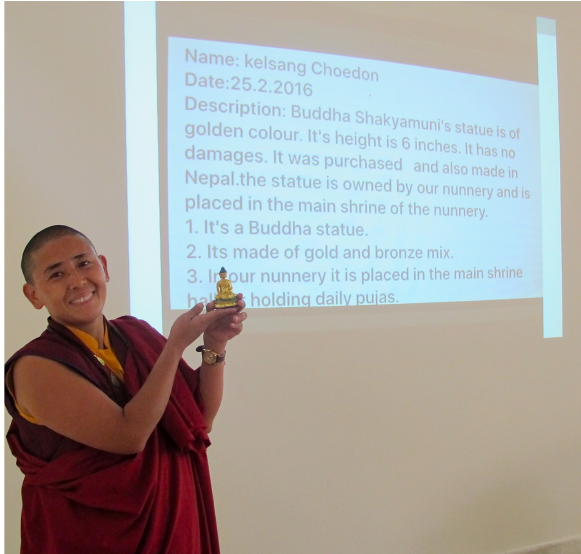
Figure 5. Participants train to share preservation skills in their home